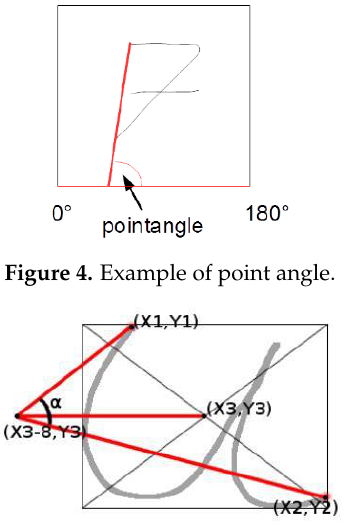
Figure 5. Example of horizontal point angle.